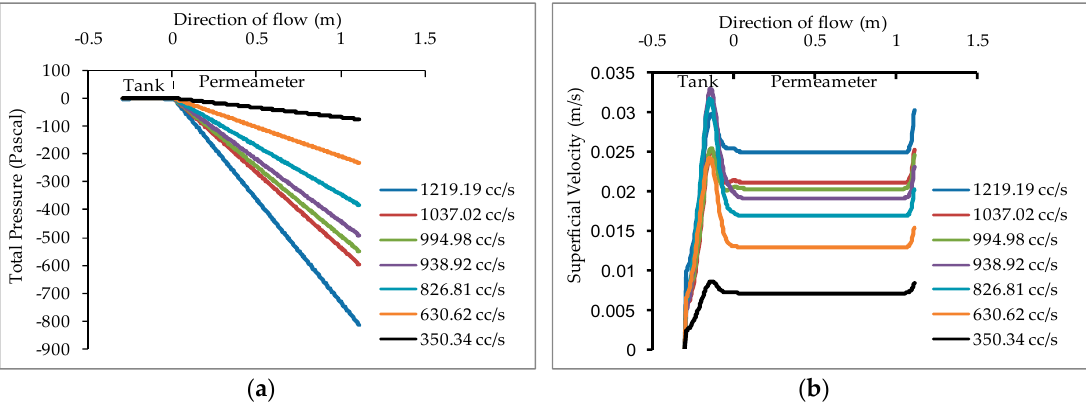
Figure 6. The values of ( a ) the total pressure and ( b ) the velocity in the direction of the flow subjected to different discharges for 29.8 mm media packed with 43.34% porosity.